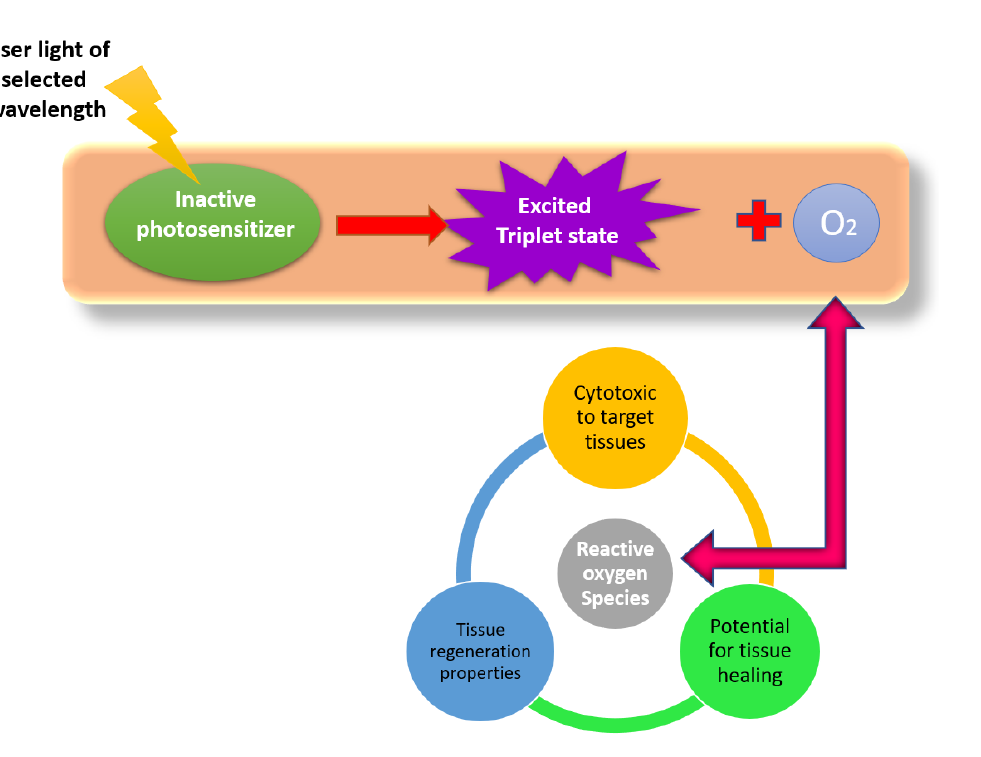
Figure 13. Mechanism of action of PDT against OLP.